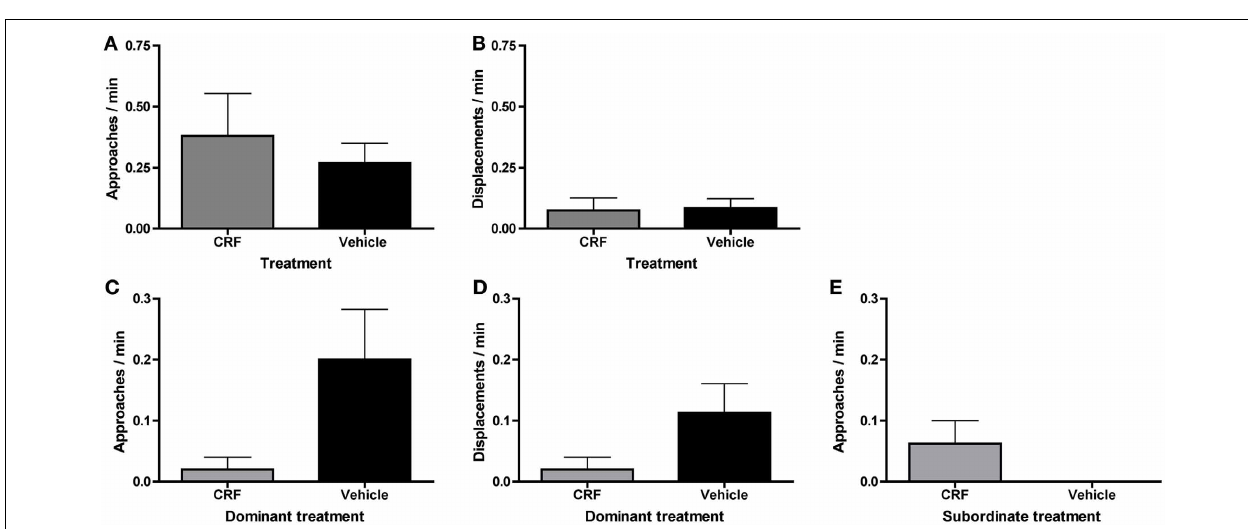
FIGURE 4 | Mean ( ± s.e.m.) agonistic behaviors within the first 30min of pairing. Injected fish (A) approached (independent t -test following natural log transformation: t = − 3 . 09, d . f . = 44, p = 0 . 0035) and (B) displaced (Mann–Whitney U -test: U = 214 . 5, n Inj = 30, n Con = 26, p = 0 . 0039) significantly less than control fish. (C) Injected fish also engaged in significantly fewer lateral displays (independent t -test following natural log transformation: t = − 3 . 53, d . f . = 24, p = 0 . 0017). Injected dominants (D)